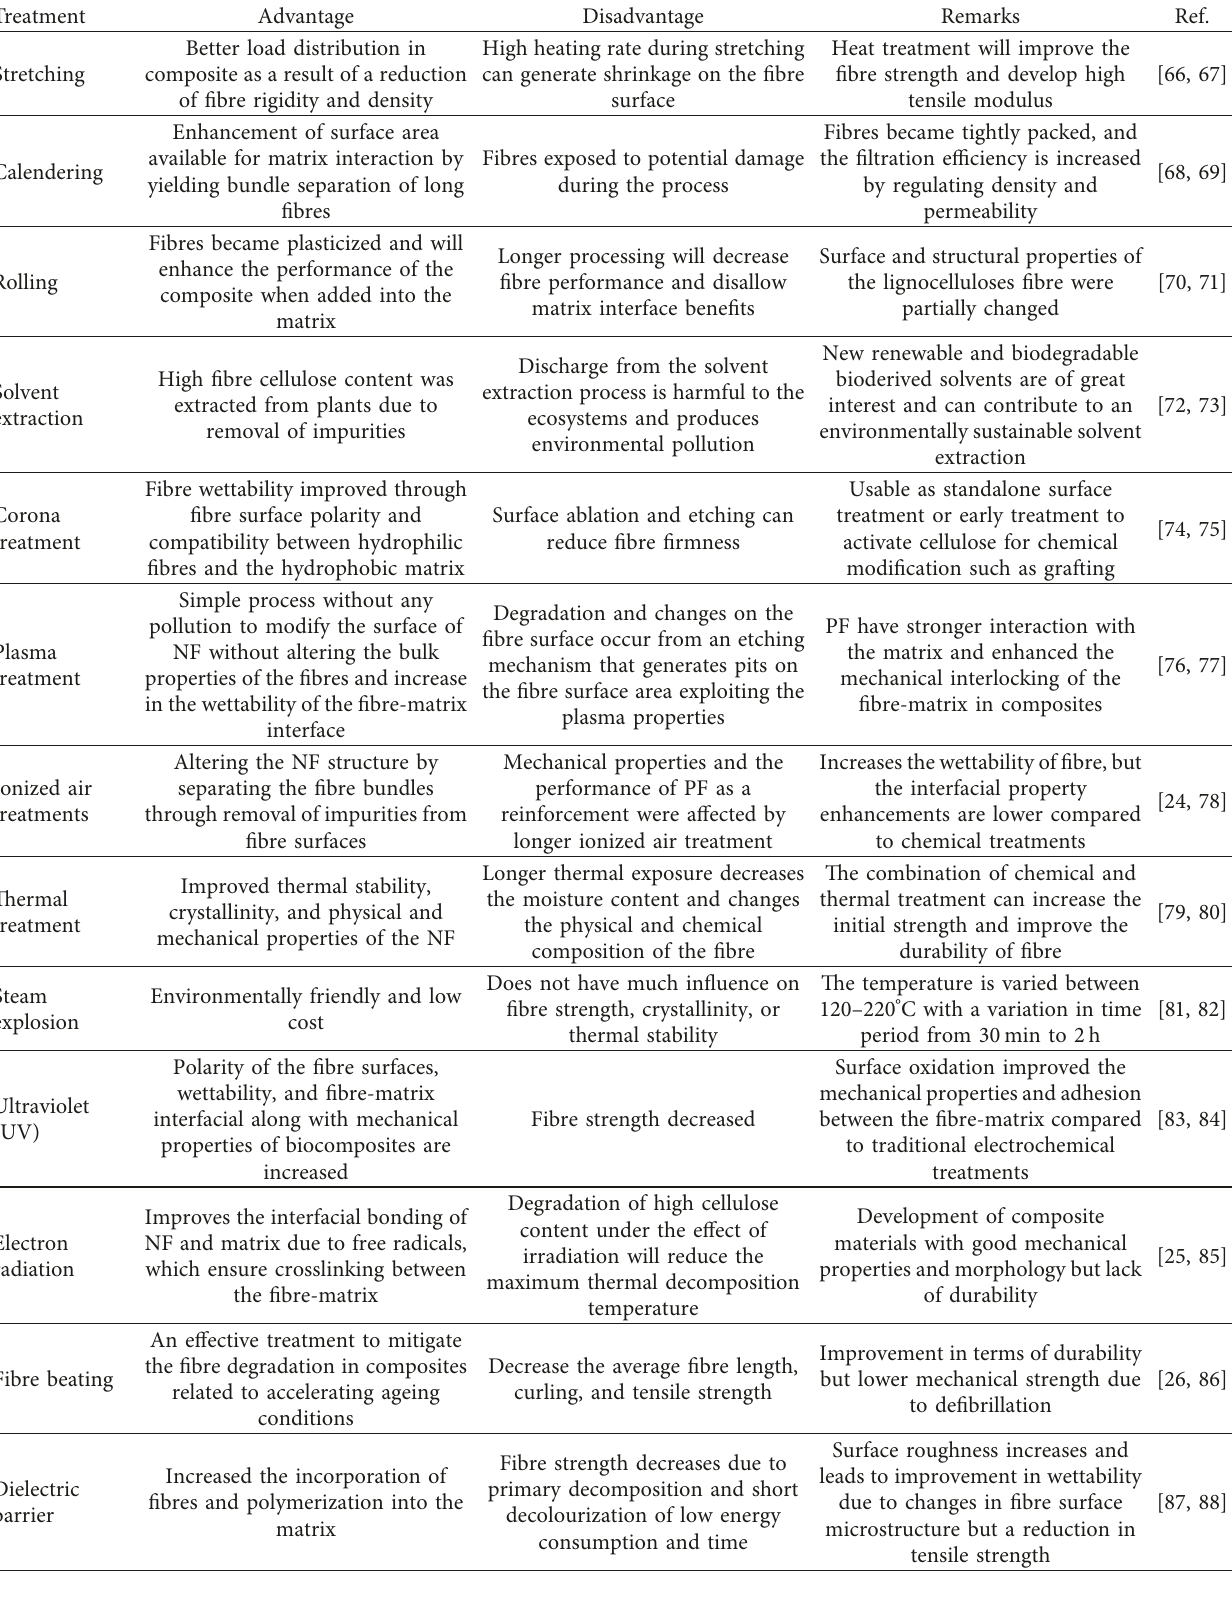
Table 3: Advantages and disadvantages of fibre physical